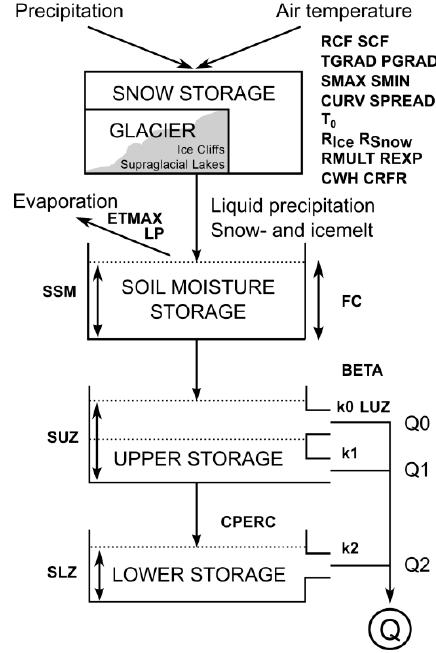
Figure 2. Structure of the HBV-LMU model. Free model parameters are given in bold. See Table 1 for abbreviations. Table 1. Model parameters. White: Parameters responsible for snow and ice melt and precipitation. Light grey: Runoff parameters considered in the third calibration run. Dark grey: Less sensitive parameters, not considered during automatic calibration.